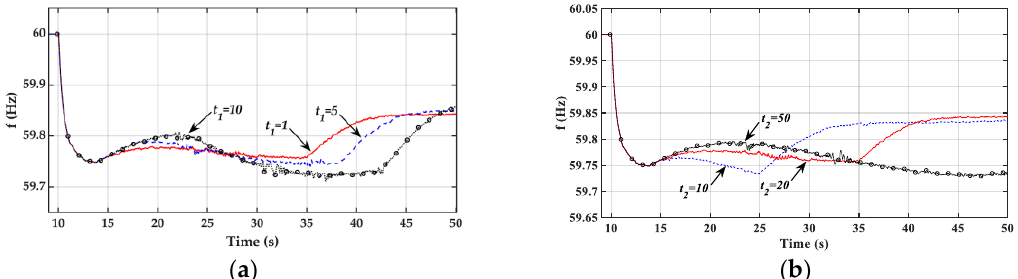
Figure 5. Effects of different delay times ( t 1 ) and decay times ( t 2 ) on system frequency. ( a ) Different delay, Table 1. ( b ) Different decay times ( t 2 ).